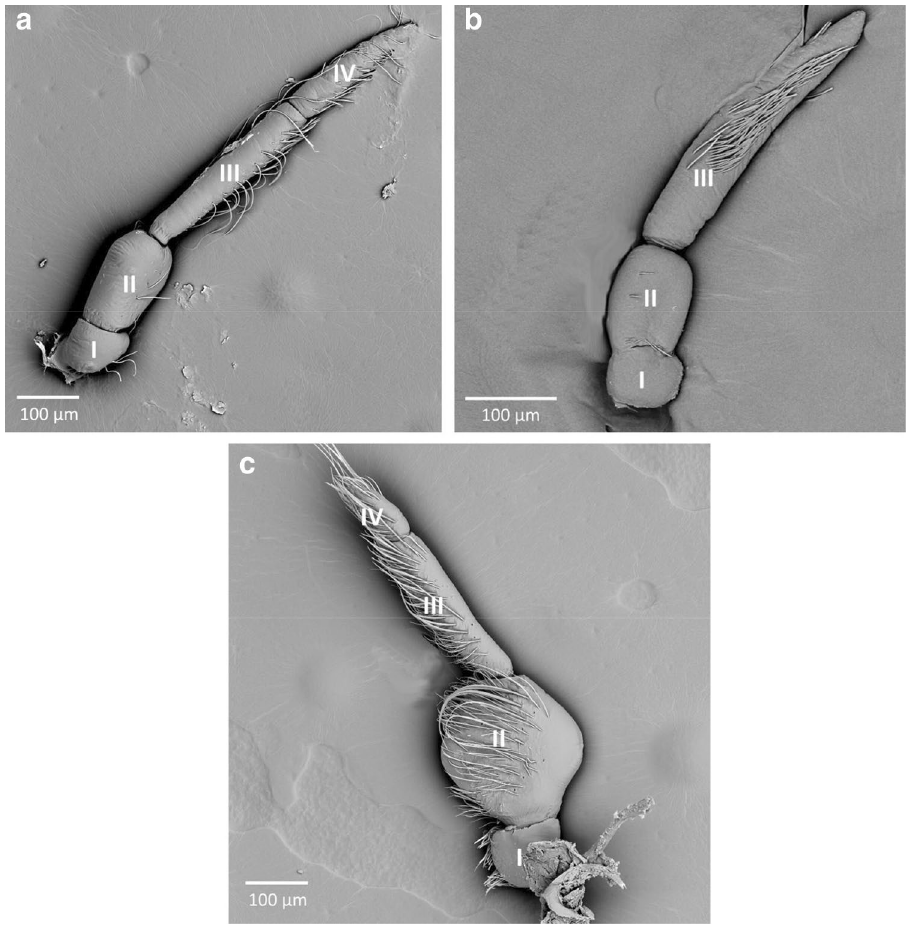
Figure 3. The antennae of Limnocorinae; ( a ) Limnocoris asper , ( b ) Limnocoris pusillus , ( c ) Limnocoris volxemi ; I–IV—numbers of